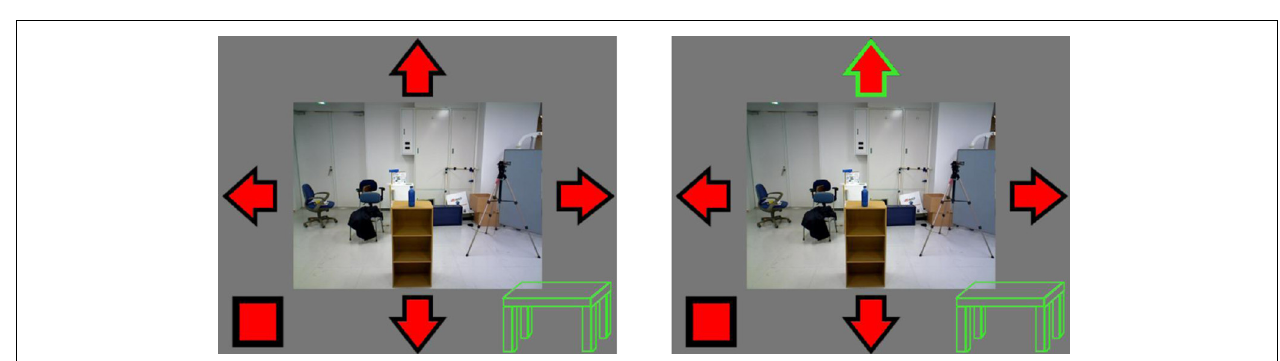
FIGURE 3 | Within the implemented graphical user interface whenever the BCI recognized a command (e.g., top arrow, forward-command), the corresponding icon’s border changed color (from black to green).